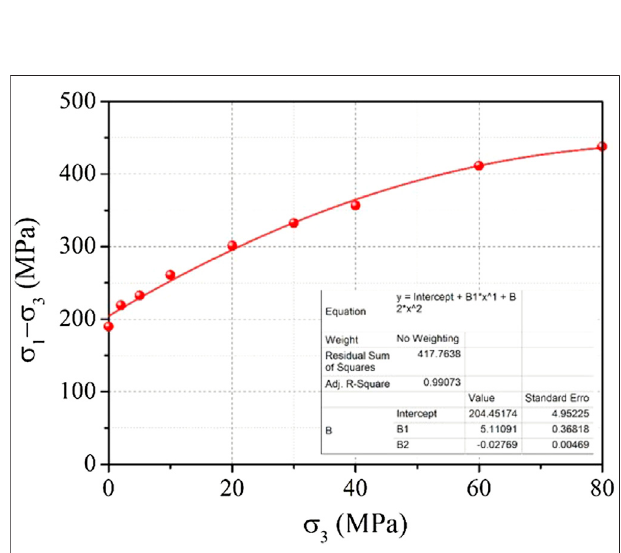
FIGURE 3 | Peak strength of the tested samples under conventional triaxial compression